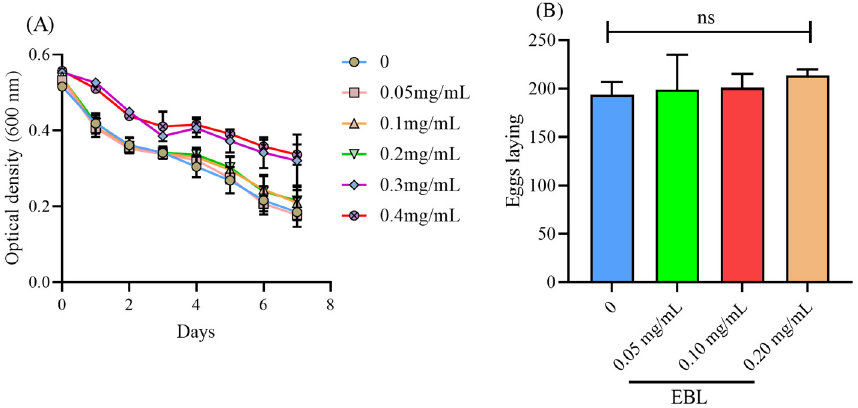
Figure 1. The effect of EBL on ( A ) food intake ability and ( B ) the brood side. Notes: ns meant not significant.